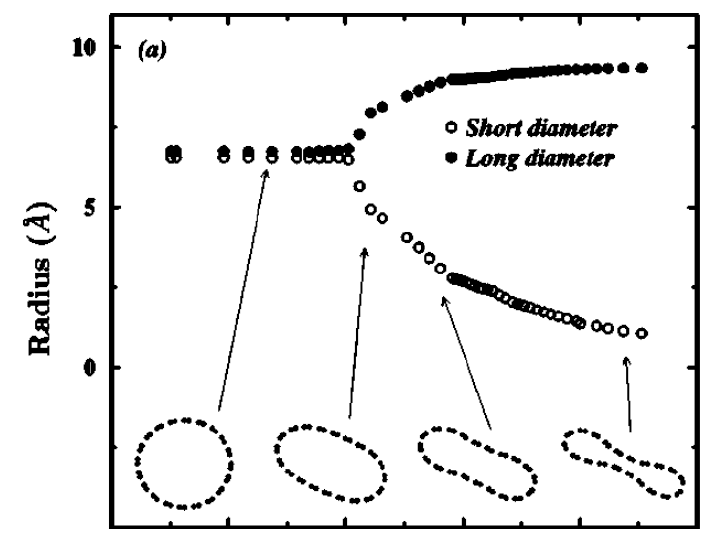
Figure 5. Long and short diameters of a (10,10) SWNT as a function of applied hydrostatic pressure. The shape of the cross section at some selected pressures is plotted at the bottom of the figure. Reprinted from Reference